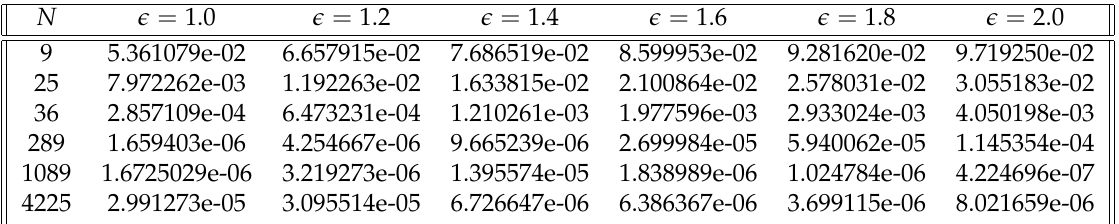
Table 3. RMSE for Example 2 over a range of shape parameter ( (cid:101)